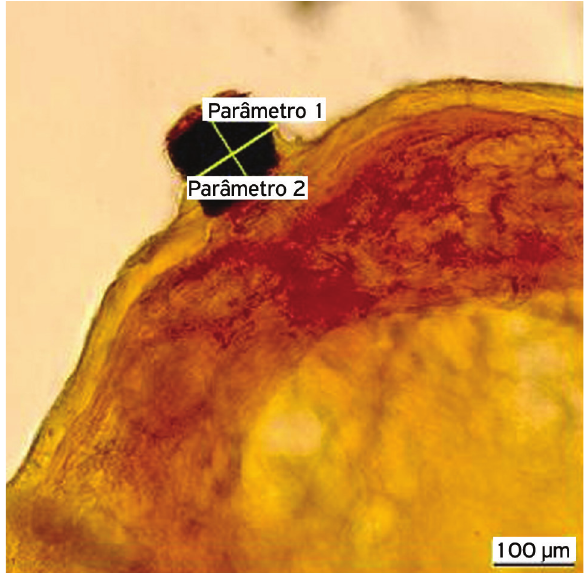
Figura 1. Parâmetros utilizados na morfometria das estruturas anteriores e posteriores das larvas de Neosilba perezi: 1. Altura dos espiráculos posteriores em vista lateral, 2. Largura dos espiráculos posteriores em vista lateral.